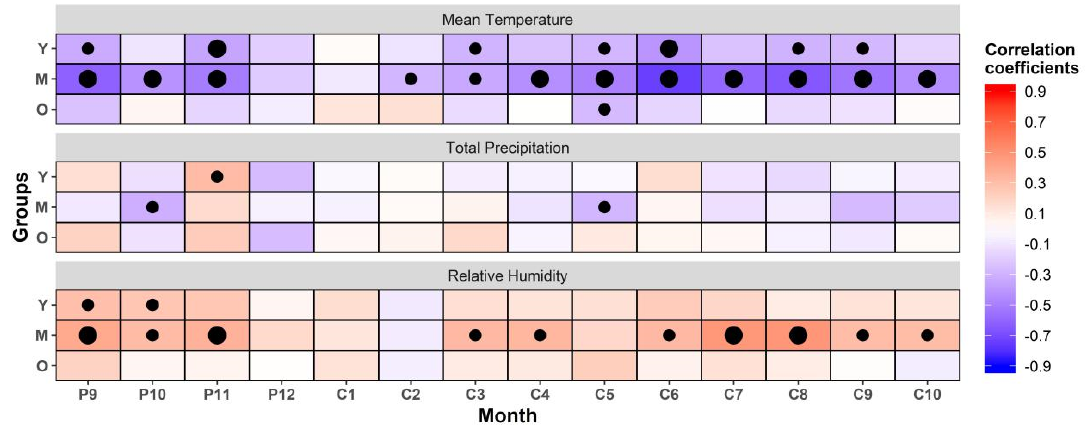
Figure 4. Correlation coefficient between the radial growth and mean temperature, total precipitation, and relative humidity in the Schrenk spruce trees of three age groups. Y: young group; M: middle-aged group; O: old group; red: positive correlation; blue: negative correlation; large black dots: significance level <0.01; small black dots: significance level <0.05; P: previous year, C: current year (for example, P9: September of the previous year, C1: January of the current year).